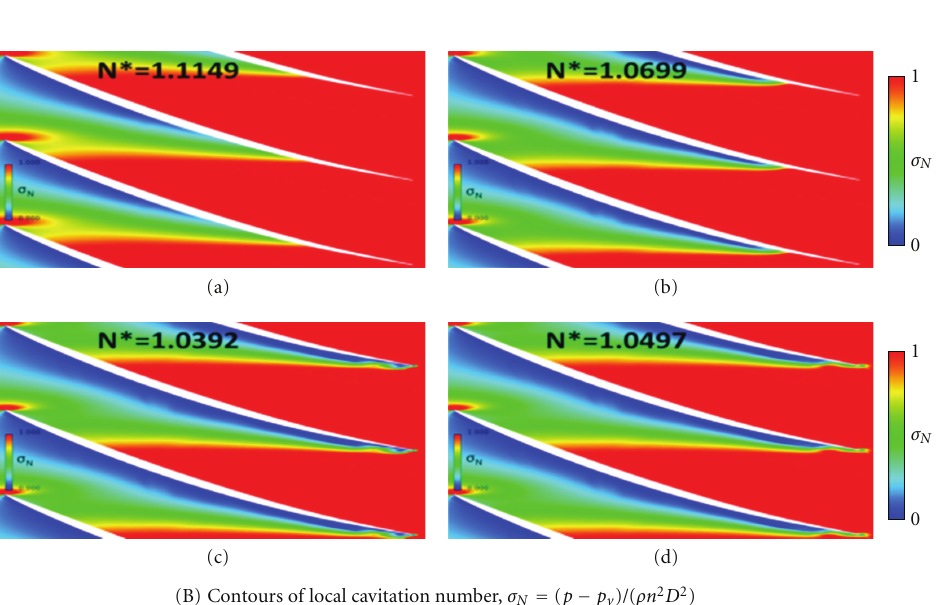
Figure 11: Computational results, constant radius cut-through rotor solution, r/R shroud = 0 . 866 (near tip), Q ∗ = 0 . 825. Results at each of four conditions, (a) ( N ∗ = 1 . 1149) (b) ( N ∗ = 1 . 0699) (c) ( N ∗ = 1 . 0392) (d) ( N ∗ = 1 . 0497), prior to and after breakdown. (A) Vapor volume fraction contours. (B) Cavitation number.